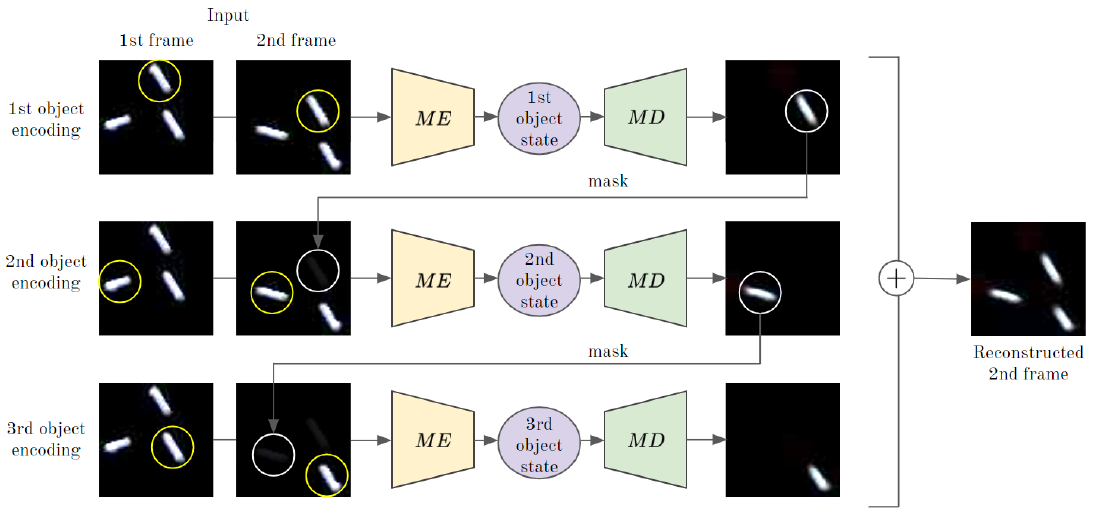
Figure 6. Encoding states of three objects.